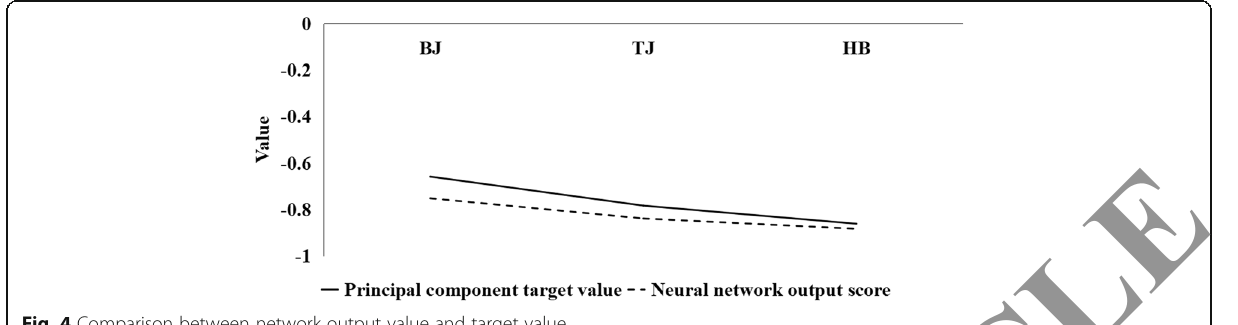
Fig. 4 Comparison between network output value and target value